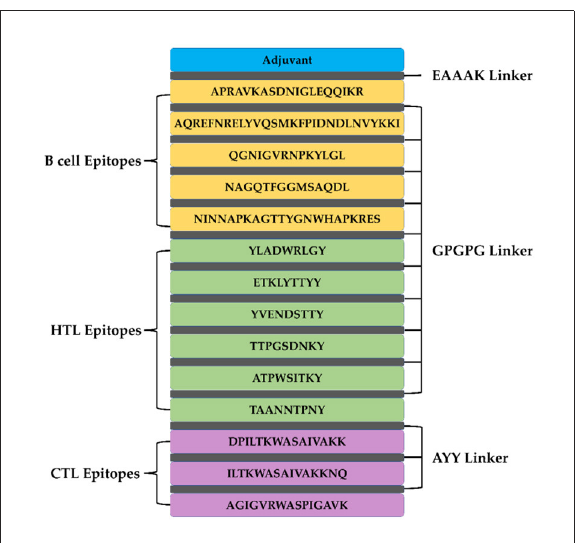
FIGURE4 The structural arrangement of B- and T-cell epitopes along with linkers and adjuvant for the final multi-epitope vaccine